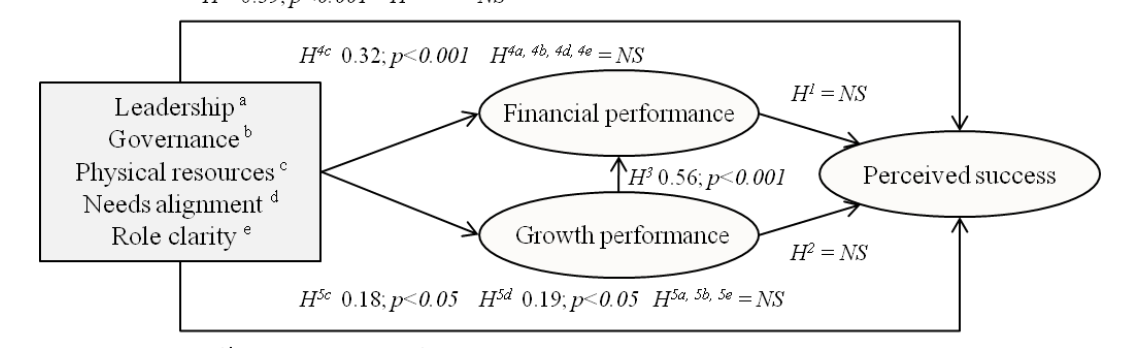
Figure 2: Summary of significant